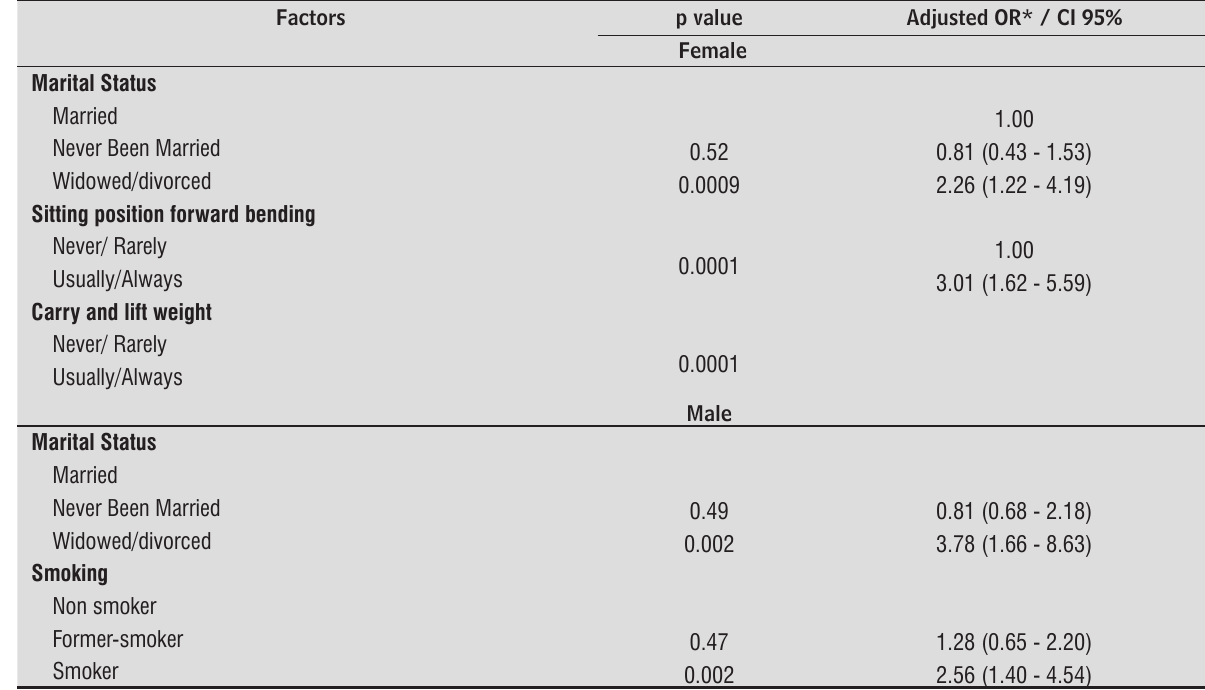
Table 5 - Final model of multivariate analysis of logistic regression for variables associations with back pain of the